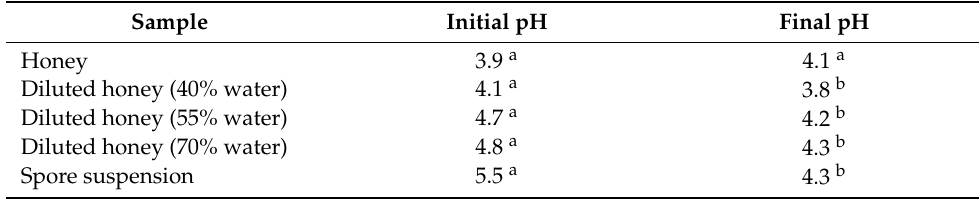
Table 2. Variation of pH due to scCO 2